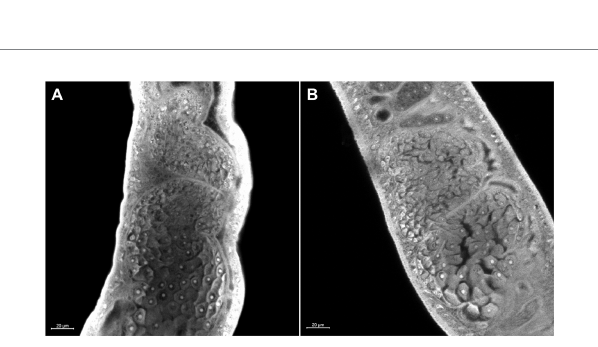
FIGURE 6 Morphology of the ovary of ex vivo Sm carm 1 knocked-down adult worms. Morphological changes in the ovary of female adult worms recovered from mice infected with schistosomula from (A) negative control and (B) Sm carm 1-dsRNA. The white bars indicate the scale 20 μ m.